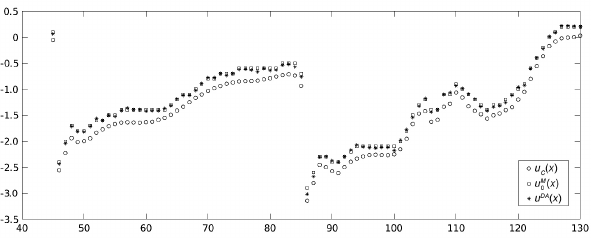
Fig. 16 Results comparison with a control variable u C for nobs =60.